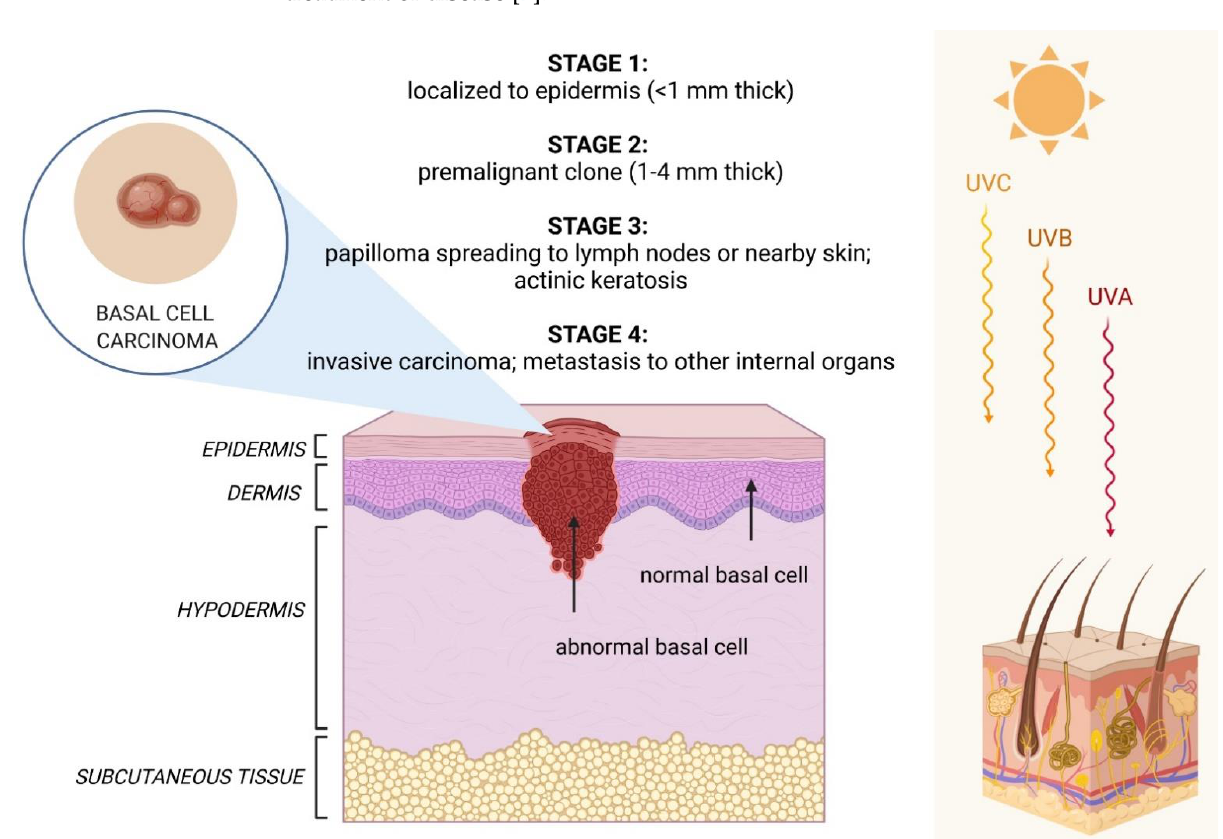
Figure 1. BCC onset related to sun exposure consisting of four stages (I-IV) (own drawing). The basal cells composing the skin are located in the basal layer of the epidermis, and during maturation, cells migrate to the surface, giving rise to the future epidermis [8,9]. The Hedgehog pathway (HH) plays a crucial role in embryonic development and adult tissue homeostasis. This pathway was first described in Drosophila but is also conservative for mammals [10]. In mammals, the HH consists of three secreted ligands: Sonic Hedgehog, Indian Hedgehog, and Desert Hedgehog. There are also transmembrane receptors: Patched 1 (Ptch1), Patched 2, and transmembrane G protein-coupled receptor Smoothened (Smo). Activation of the HH results in stimulation of transcription factors, such as Gli1, Gli2, and Gli3. There is also a suppressor of fused homolog (SUFU), which can modulate Gli activation.